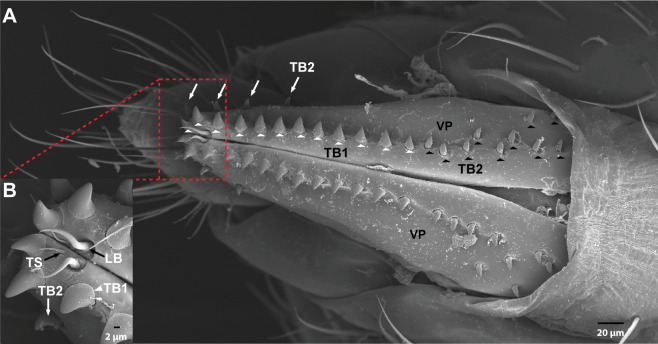
The ovipositor in Drosophila suzukii.(A) Scanning electron micrograph of the ovipositor of D. suzukii showing bristles on each vaginal plate (VP). White arrowheads = thorn bristles type 1. White arrows and black arrowheads = thorn bristles type 2. (B) The distal part of the ovipositor of D. suzukii showing trichoid sensillum (TS), long bristle (LB), and thorn bristle type 1 (TB1). Extended description: Three TS are at the distal end of each VP (B). Each is inserted in a basal socket, is ~10 μm in length, and tapers to a fine tip. One LB, ~25 μm in length, is at the distal end of each VP (B). Each LB has a large socket and a smooth, slender, curved shaft that ends in a fine tip. TB1 are stout, blunt-tipped bristles ~14 μm in length (white arrowheads in A). There are 12–14 TB1 in a row, close to the distal lower margin of each vaginal plate. They have a longitudinally grooved shaft inserted in a narrow socket. This type of bristle has no counterpart in D. melanogaster, and could conceivably function in evaluation of the stiffness of oviposition sites; D. suzukii differs from related species in its preference for substrate stiffness. TB2 are similar to TB1 but are less stout, have wider sockets, and are located in two groups. The first group is a row of four bristles of variable size (A, white arrows), located on the upper margin of the distal half of each vaginal plate. The second group consists of 10–15 bristles (A, black arrowheads) in variable locations on the proximal half of each vaginal plate. In D. melanogaster, this type of bristle is represented only by a row of 10–15 bristles along the length of each vaginal plate (Hodgkin and Bryant, 1978; Lauge, 1982).